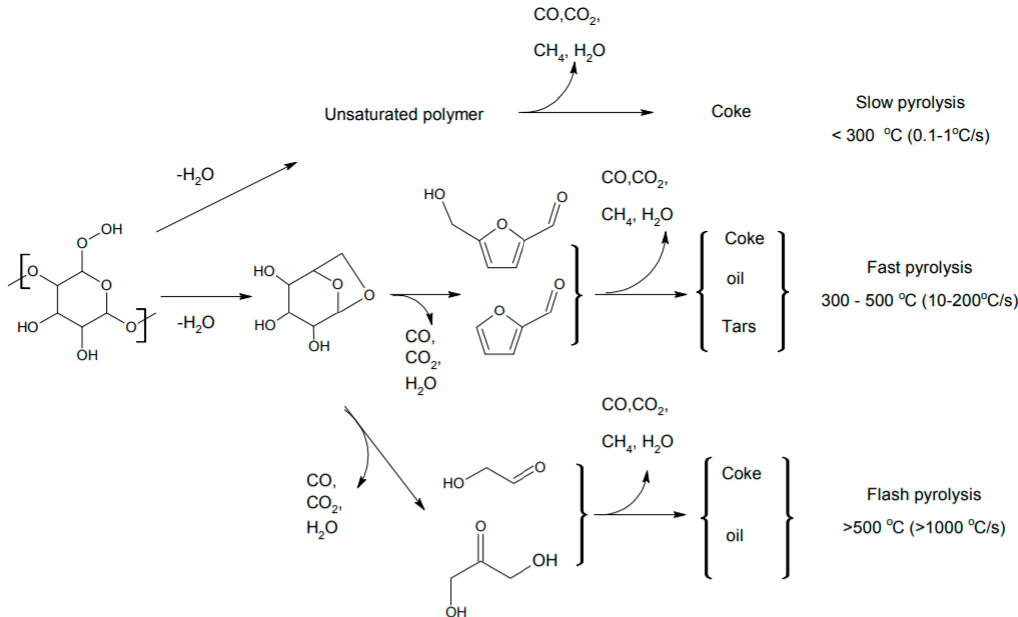
Figure 3. Reaction pathway of cellulose pyrolysis [59].